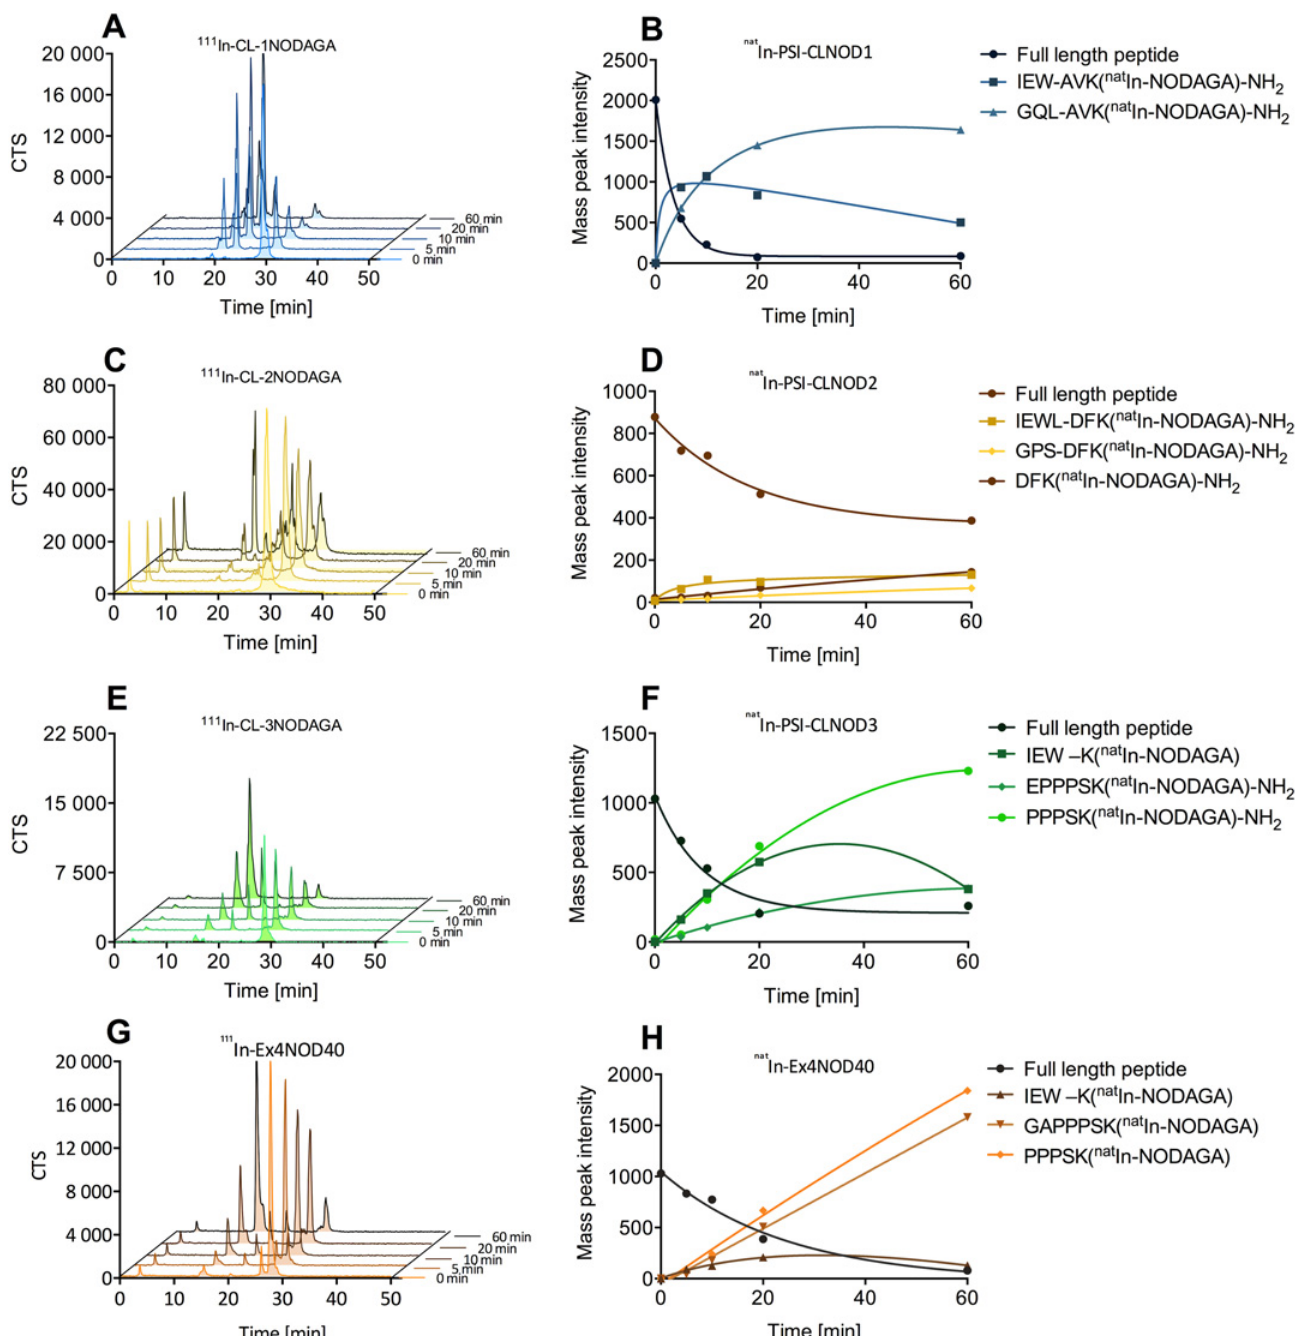
Fig 6. Digestion of In-labelled probes with recombinant meprin α . A, C, E, and G show the metabolism of the corresponding 111 In-labelled peptides. Curves B, D, F and H show the degradation of the corresponding nat In-labelled peptides and the formation of different fragments over time.